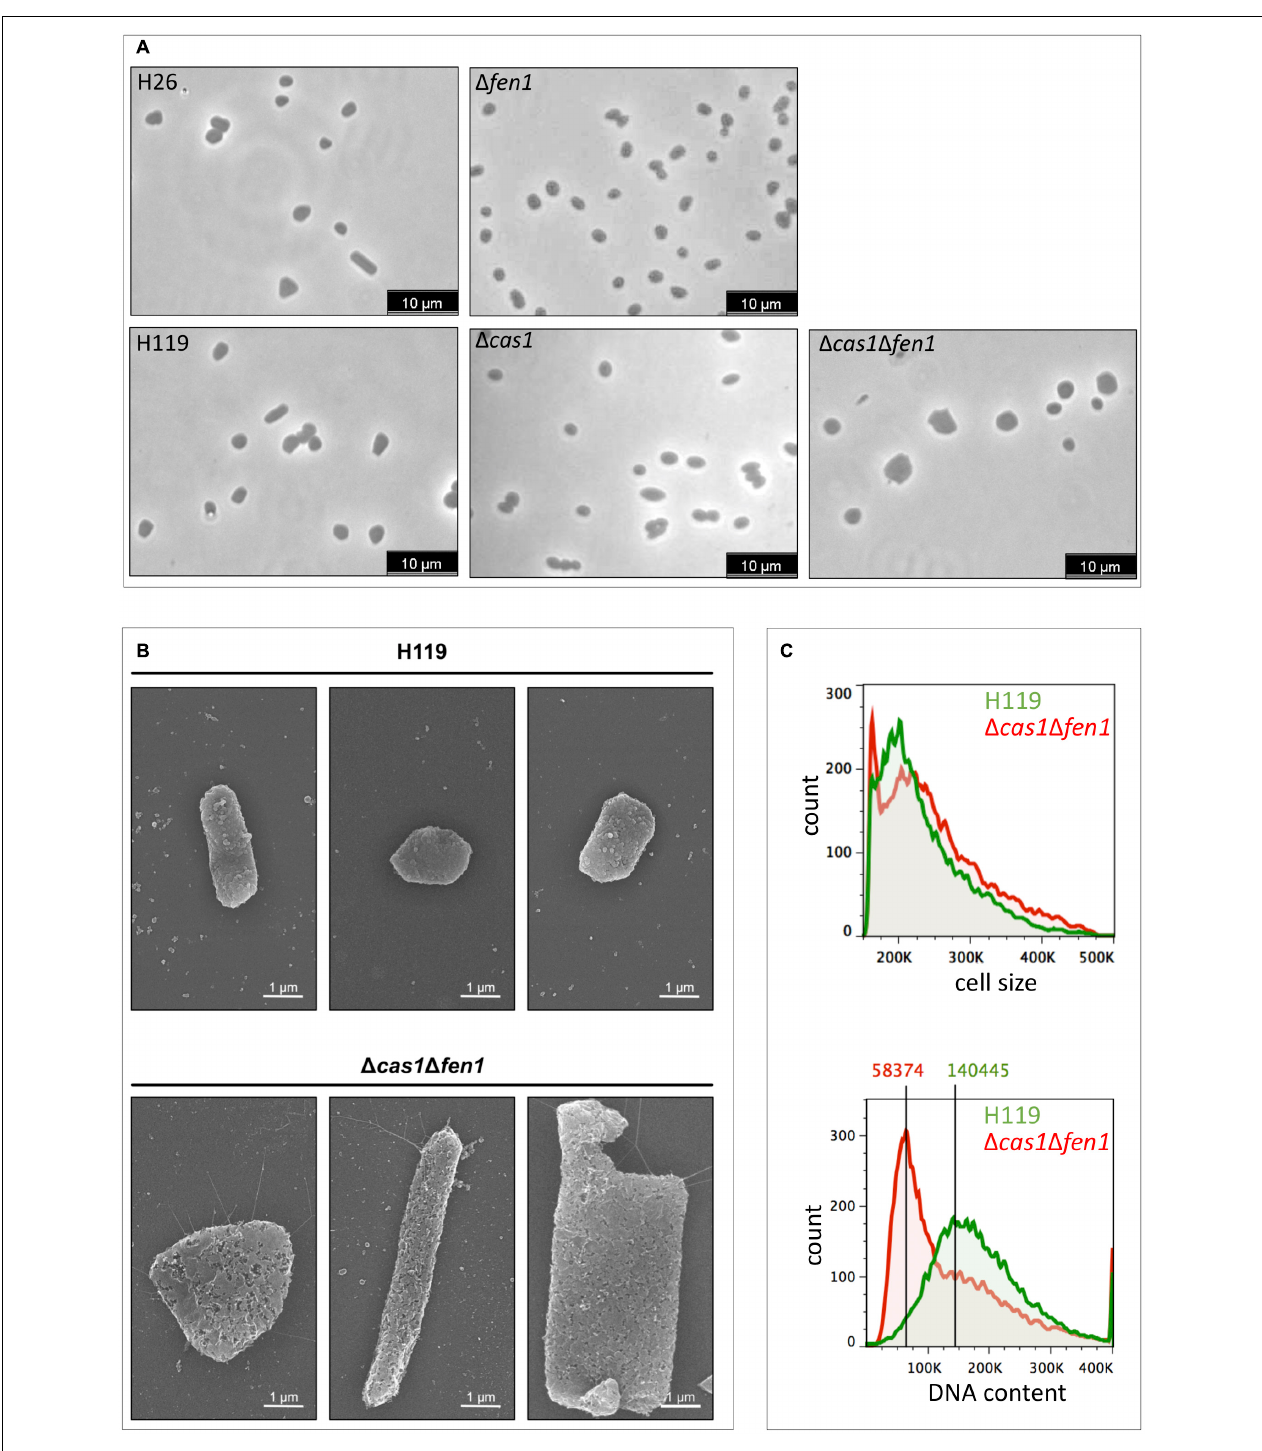
FIGURE 3 | Cell morphology and DNA content of wild-type and the (cid:49) cas1 (cid:49) fen1 deletion strain. (A) Haloferax volcanii wild-type and deletion strains were grown to mid-log growth phase and cell morphology was analysed by light microscopy. (B) Scanning electron microscopic pictures of wild-type strain H119 (upper panel) and (cid:49) cas1 (cid:49) fen1 (lower panel) grown to stationary phase. (C) Flow cytometry of wild-type H119 (green) and (cid:49) cas1 (cid:49) fen1 deletion strains (red) grown to mid-log growth phase. The FS (forward light scatter) channel was used to evaluate cell size (upper panel) and the FL1 (fluorescence 1) channel was used to evaluate the DNA content of acridine orange-stained cells (lower panel). Modal population values for DNA content highlights a decreased DNA content in the (cid:49) cas1 (cid:49) fen1 mutant (41.5% of wild-type value).